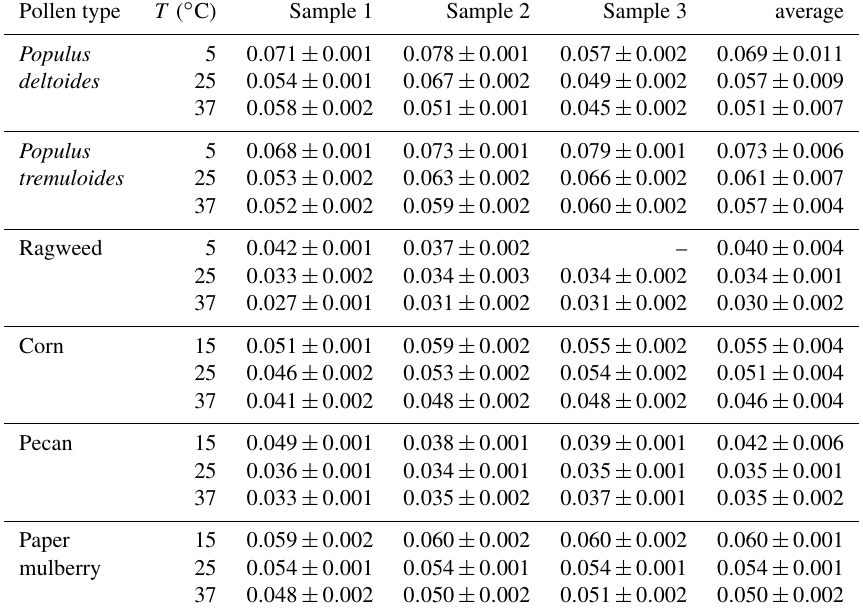
Table 3. Single hygroscopicity parameters ( κ ) derived in this work for the six pollen species at different temperatures. All the errors given in this work are standard